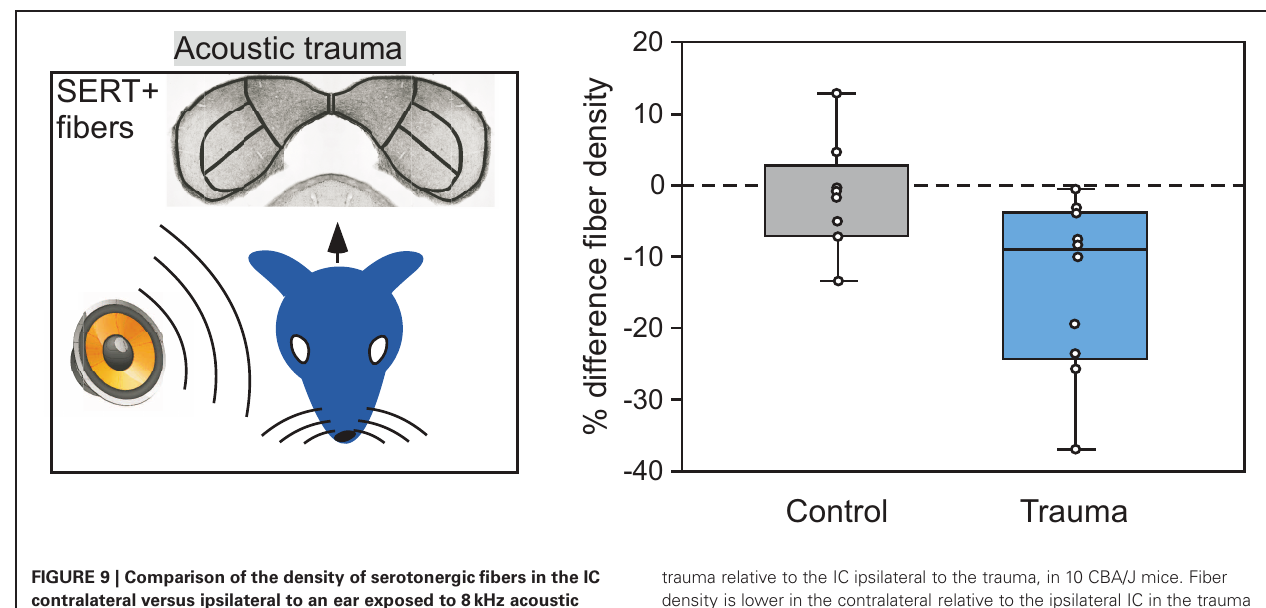
FIGURE 9 | Comparison of the density of serotonergic fibers in the IC contralateral versus ipsilateral to an ear exposed to 8kHz acoustic trauma. Left panel depicts the monaural trauma and subsequent immunolabeling of SERT-positive projections in the IC. Right panel shows percentage differences in fiber density in the IC contralateral to acoustic